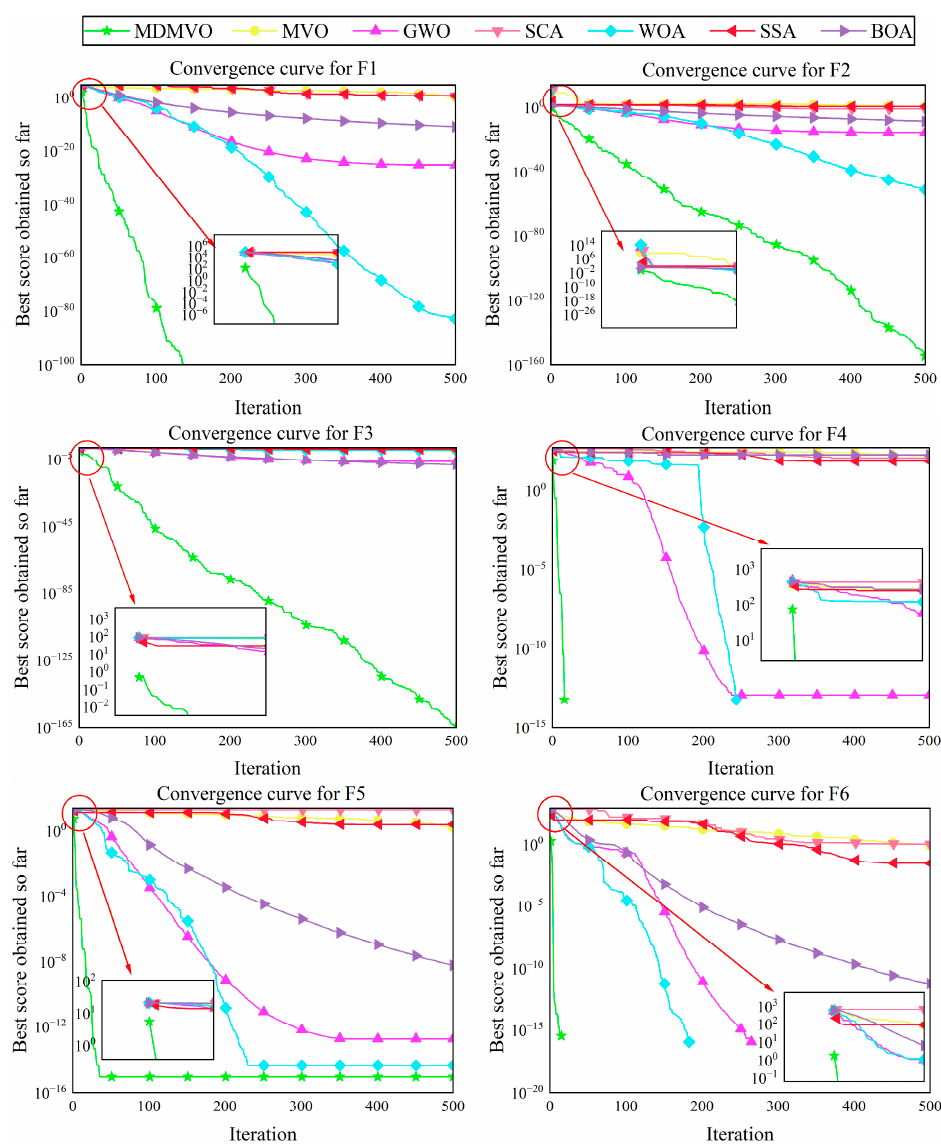
Figure 9. Convergence curves of seven methods on test functions F1, F2, F3, F4, F5 and F6.